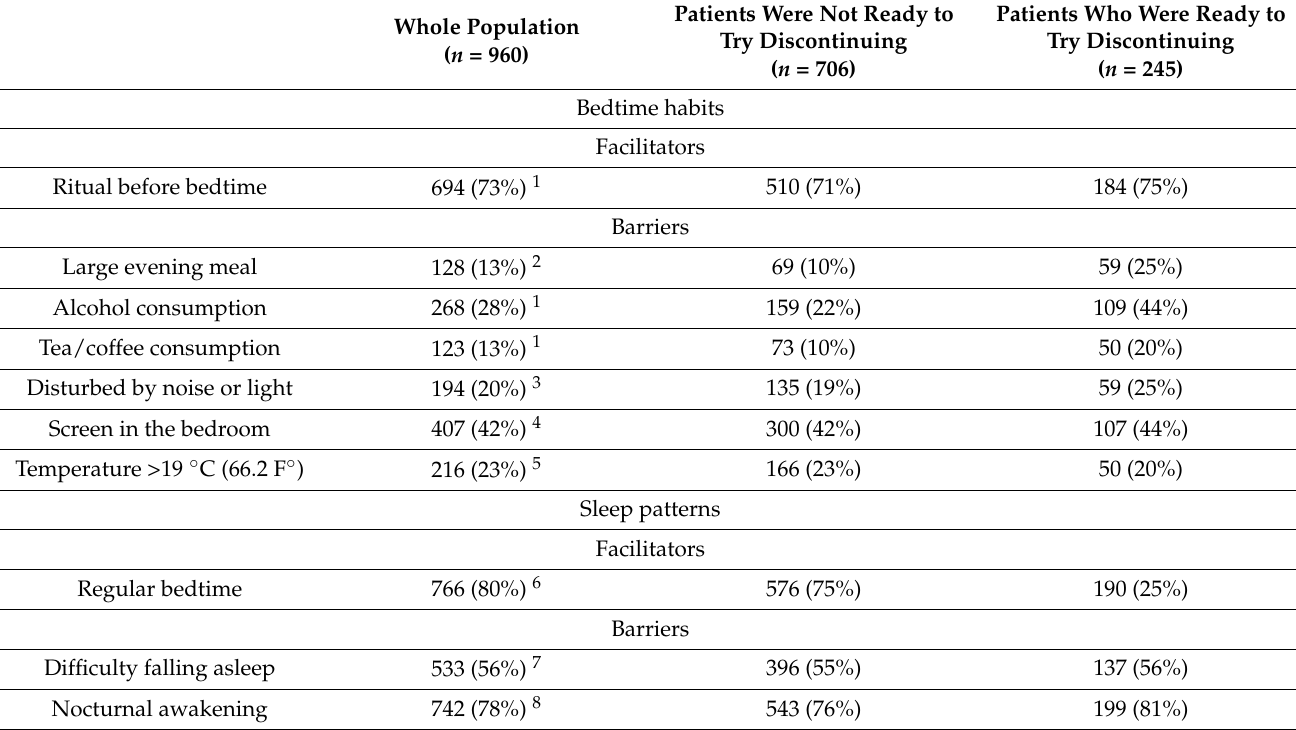
Table 1. Bedtime habits and sleep patterns.